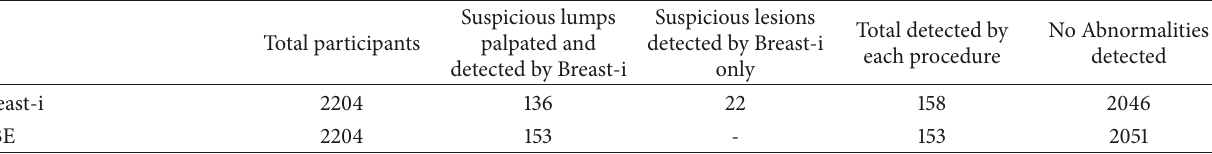
Figure 4: Images of lesions detected by Breast-i . (a) Impalpable lesion (arrowed) in a 36 year old near the axillary tail of breast. Tissue analysis revealed a malignant lesion. (b) Palpable recurring bloody cyst (arrow) in a 47 year old. Tissue analysis revealed a malignant lesion. (c) Leaky blood vessel (arrow) in a 50 year old. No malignancy associated. (d) Thick white arrow points at impalpable tender lesion in a 28 year old. The tissue analysis was consistent with mastitis. Table 2: Suspicious cases as per procedure of detection.